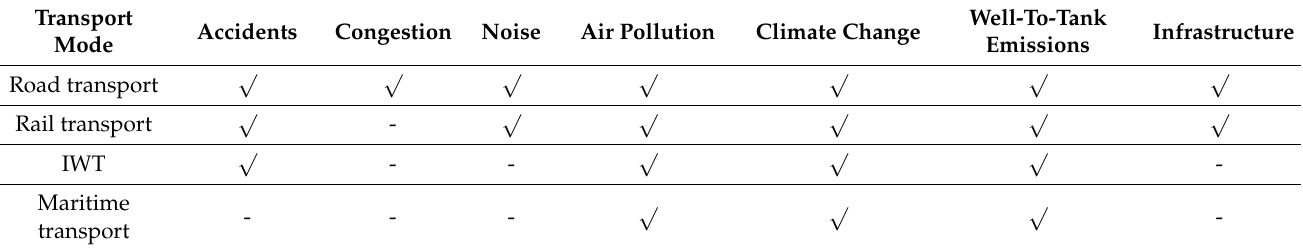
Table 1. External costs considered per transport